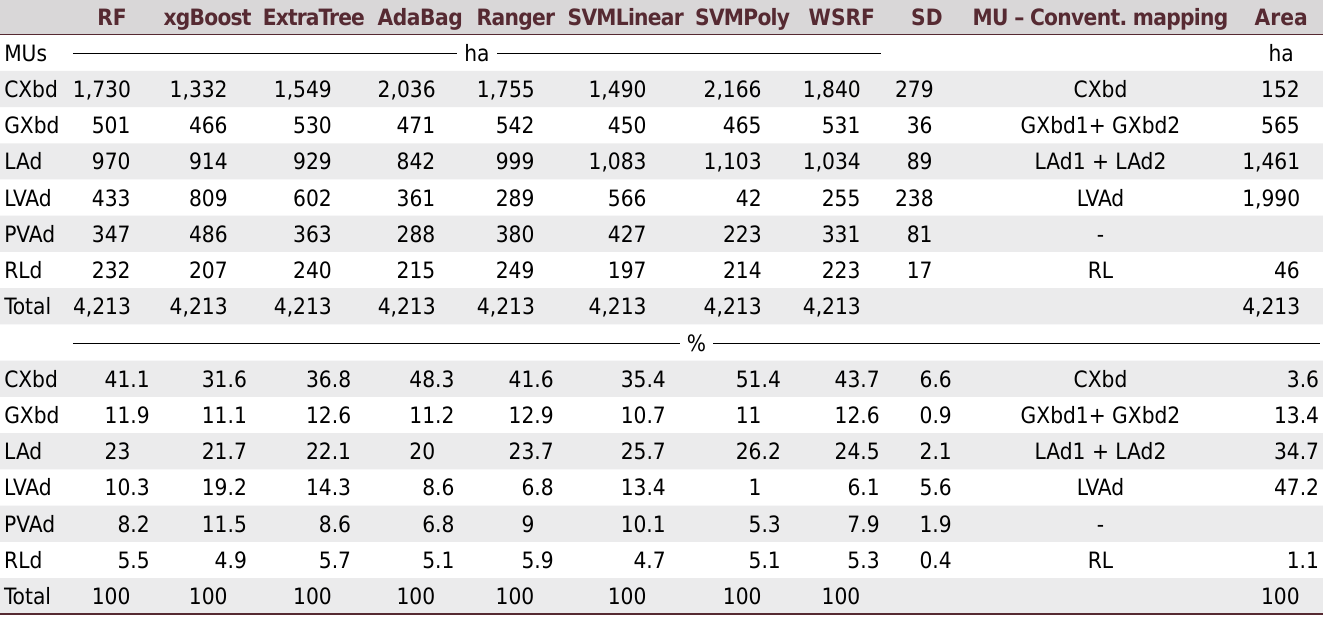
Table 3. Area of the soil mapping units in the Dênis Gonçalves settlement mapped by each machine learning classifier evaluated and by conventional soil mapping RF xgBoost ExtraTree AdaBag Ranger SVMLinear SVMPoly WSRF SD MU – Convent. mapping Area MUs ha ha CXbd 1,730 LAd